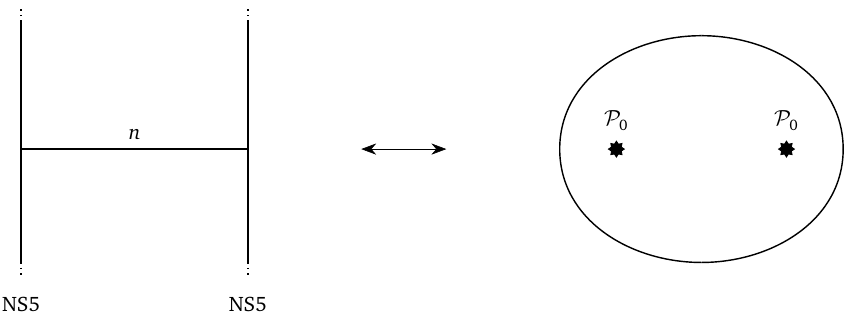
( 2,0 ) theory com- n − 1 . 0